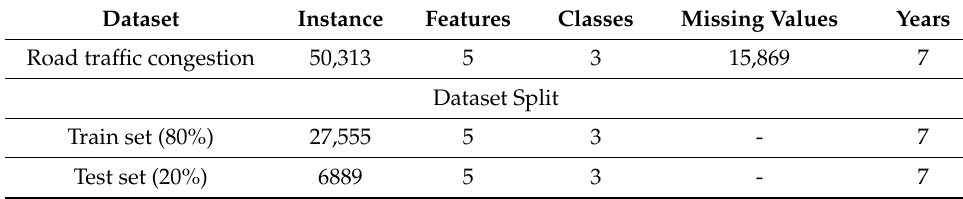
Table 3. Summary of the road traffic congestion dataset.